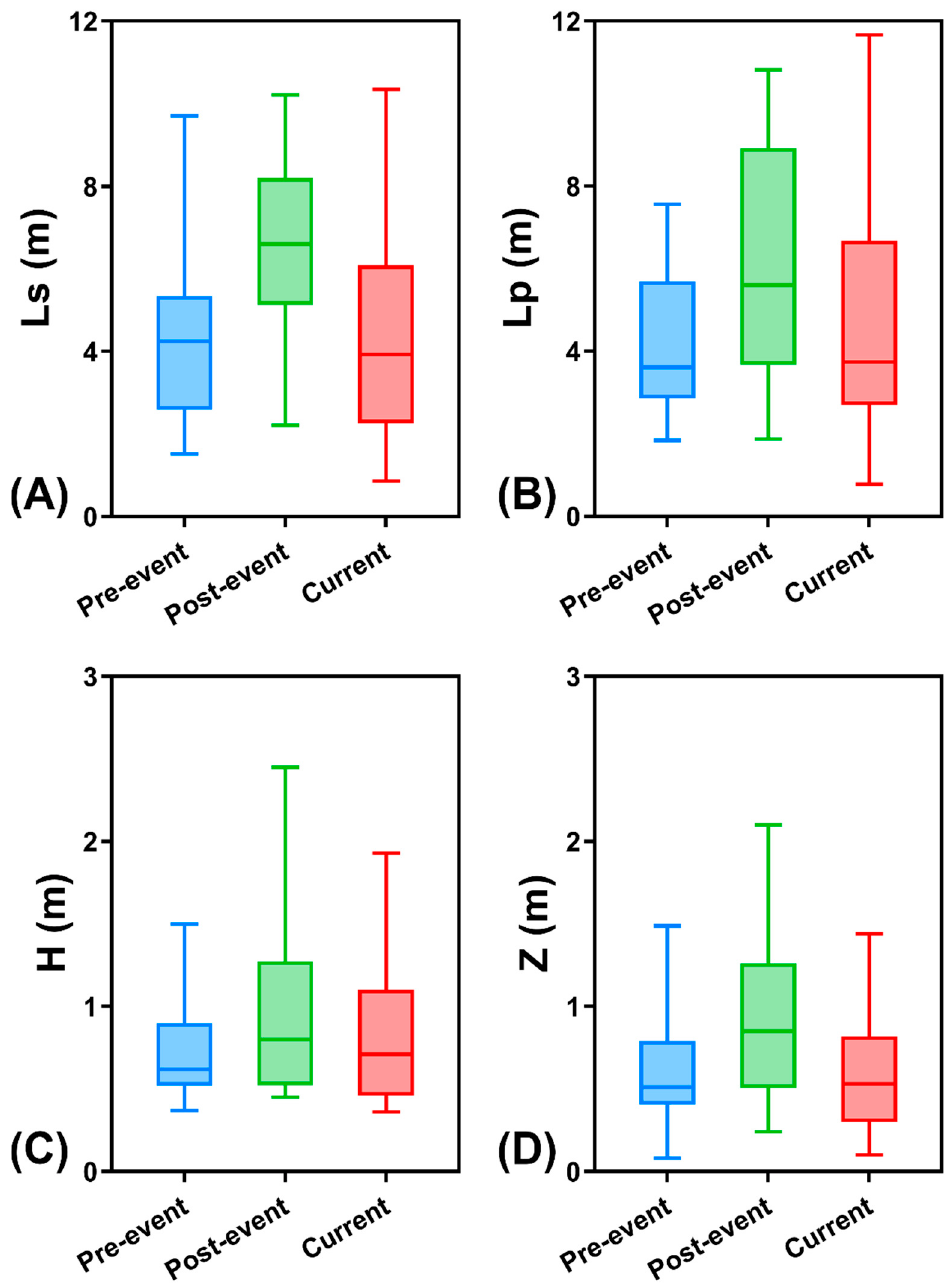
Figure 6. Distribution of ( A ) step–step spacing (Ls), ( B ) pool–pool spacing (Lp), ( C ) step–pool height (H), and ( D ) step–step drop (Z) values in the pre-event, post-event, and current conditions.